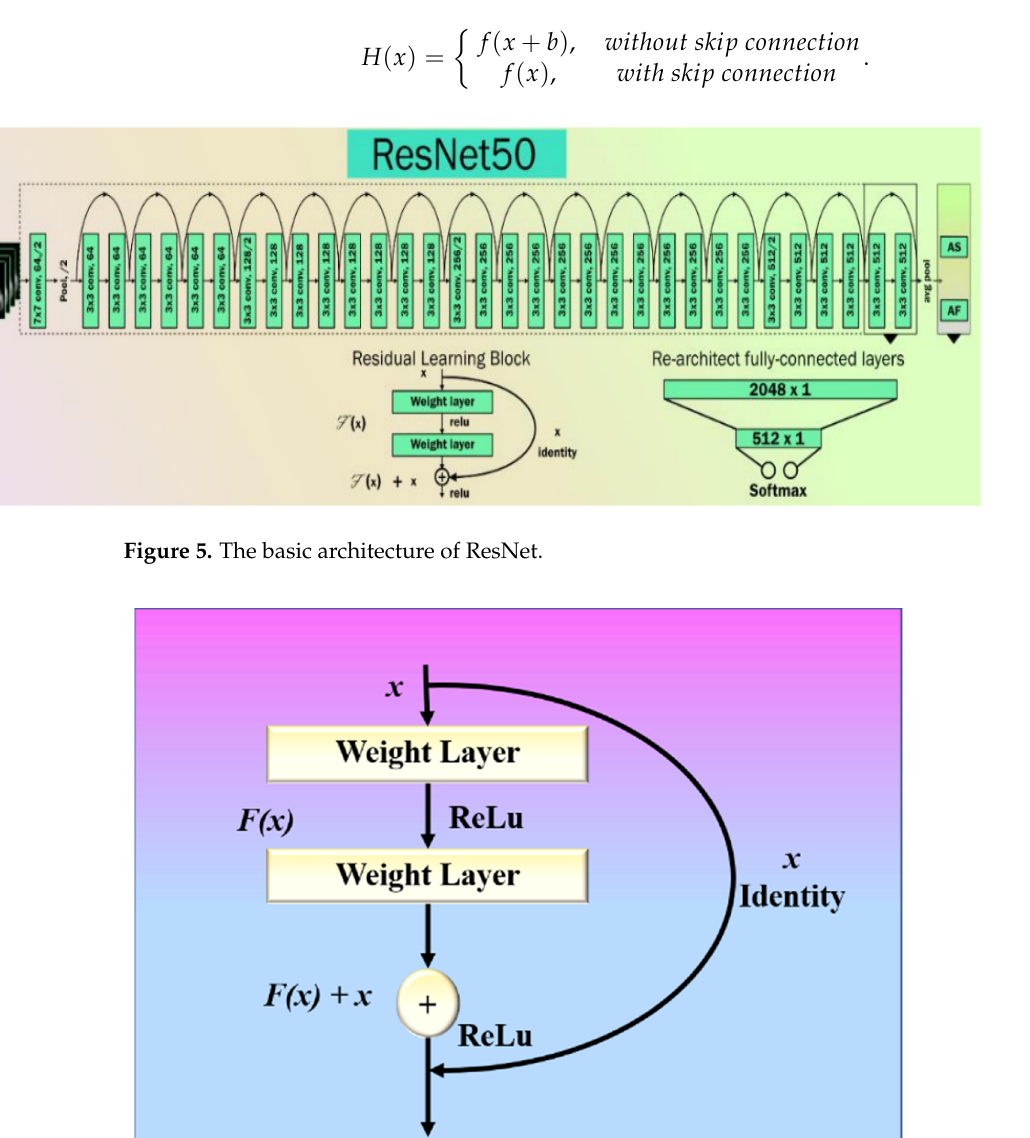
Figure 7. The basic architecture of VGG Net [73] (reproduced with permission); CONV: convolu- tion layer and FC: fully connected network.